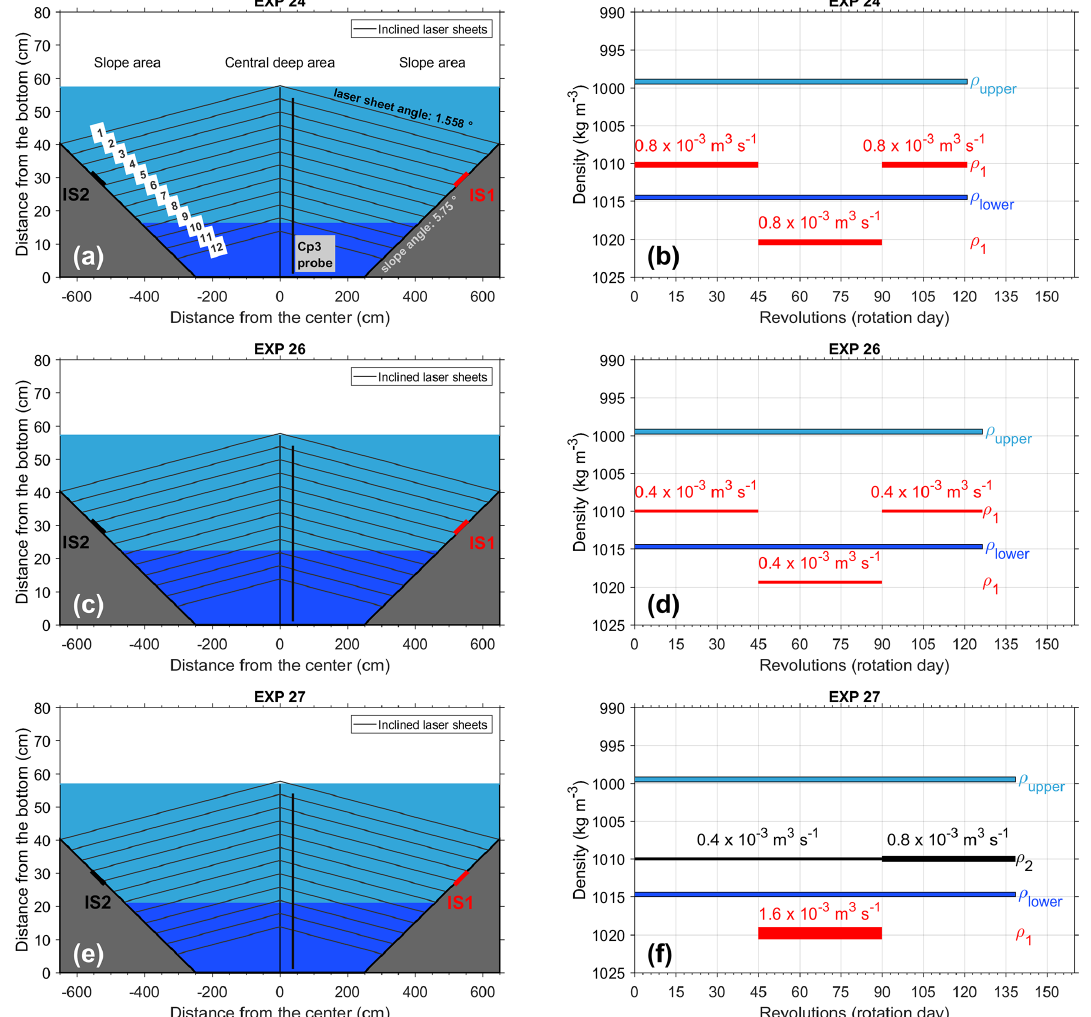
Figure 2. Scheme of the rotating tank (not to scale) and density configuration for the three experiments discussed in the paper, EXP 24, EXP 26, and EXP 27. Panels (a), (c) , and (e) give a cross-sectional view showing central deep and slope areas as well as injectors IS1 and IS2; a vertical bar near the center of the tank indicates the location of the vertical profiler Cp3; blue (cyan) shading refer to the lower (upper) layers; numbers from 1 to 12 indicate inclined laser sheet levels. Panels (b), (d) , and (e) display the initial density in the lower and upper layers (respective blue and cyan bars) along with density and discharge rates of the injected water; red (black) bars correspond to IS1 (IS2); the thickness of the bars corresponds to discharge rates during various phases (for details, see Tables 1 and 2). Only in EXP 27 were both injectors active.